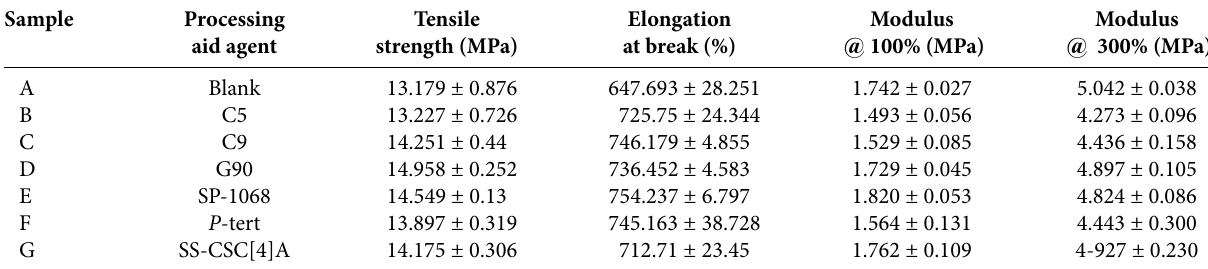
Table 4. The results of mechanical properties of rubber